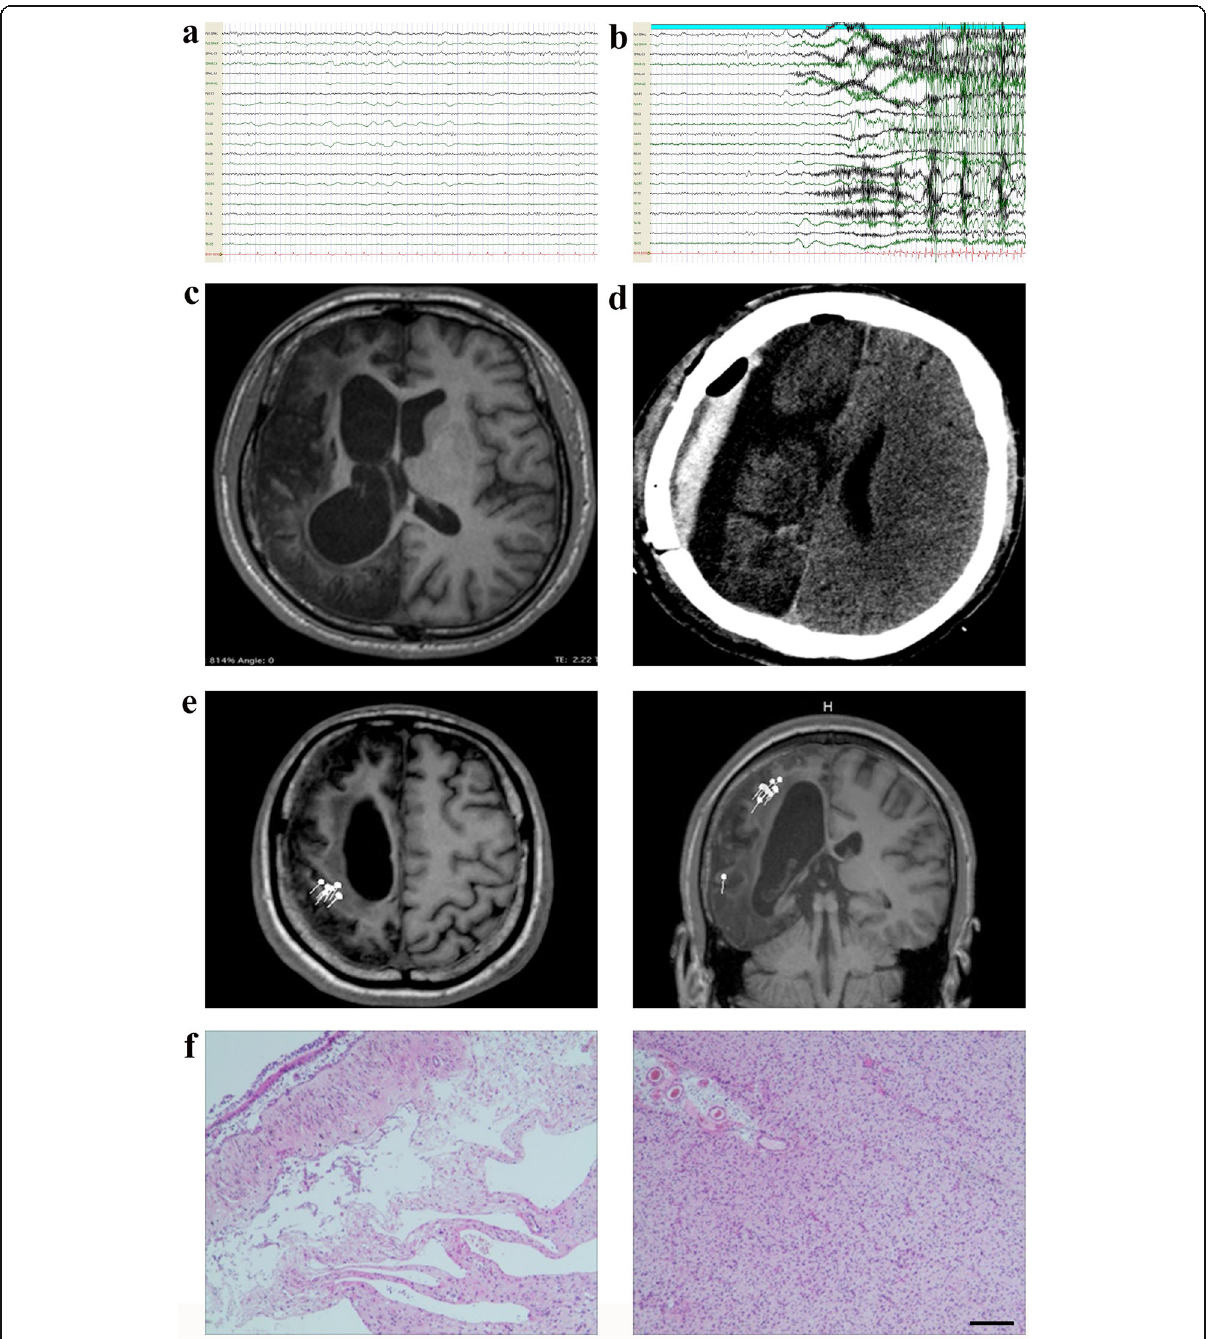
Fig. 2 Clinical data of case 2. a Interictal EEG showed slow wave on the right frontal, temporal and parietal regions. b Ictal EEG showed slow wave on the right frontal and temporal regions. c Axial MRI showed atrophy of the right hemisphere. d Post-operative CT. e MEG showed interictal dipoles concentrated in the right central-parietal region and scattered in the right middle-posterior temporal region. f Pathological result showed cicatricial gyrus formation. Scale bars: 100 μ